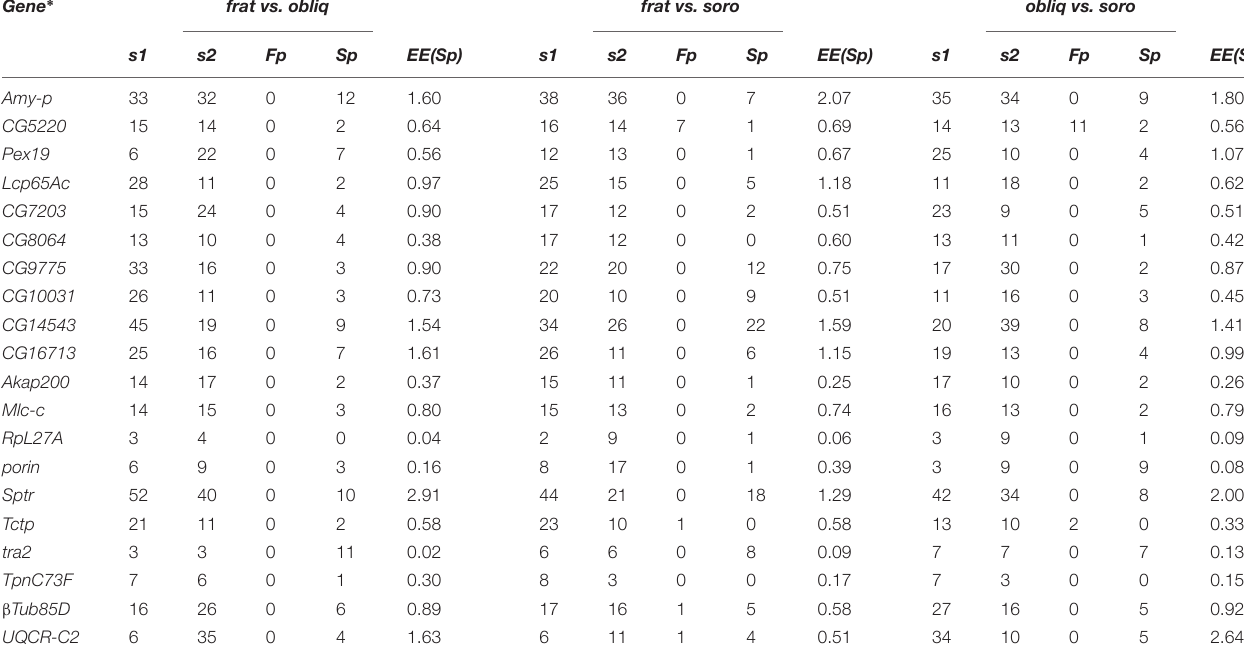
TABLE 3 | Shared polymorphism and fixed differences between pairwise comparisons of Anastrepha species.